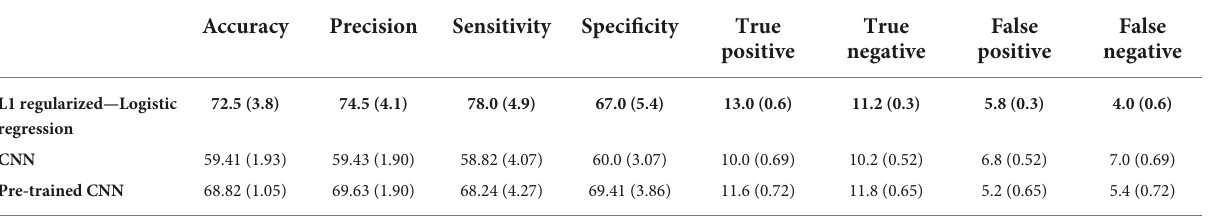
TABLE 2 Performance of models using 5 × 10-fold Cross-validation—Mean (standard error).